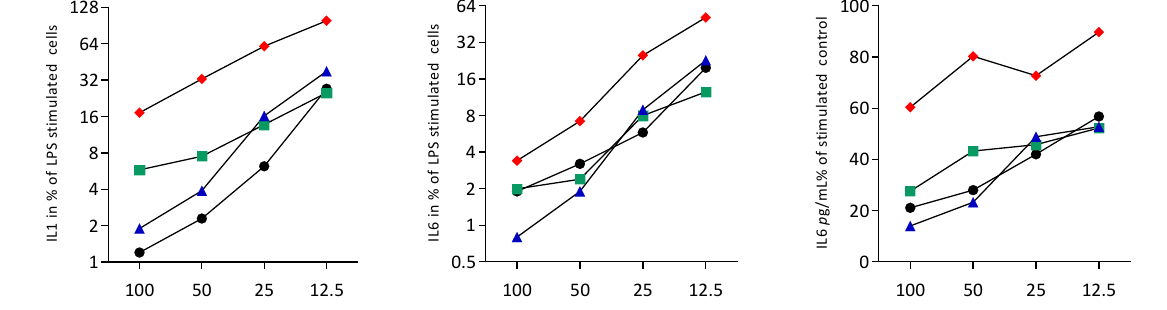
Figure 3. Dose-response of sonicated necrotic cell lysates reduce cytokine expression in RAW264.7 cells. RAW264.7 macrophages were exposed to LPS with and without different percentages of sonicated cell lysates (12.5, 25, 50, and 100%) from gingival fibroblasts (black), HSC2 (green), TR146 (blue), and RAW264.7 (red). The percentage of LPS-stimulated control expression (100%) is shown. The dot plots represent the mean of two independent experiments.